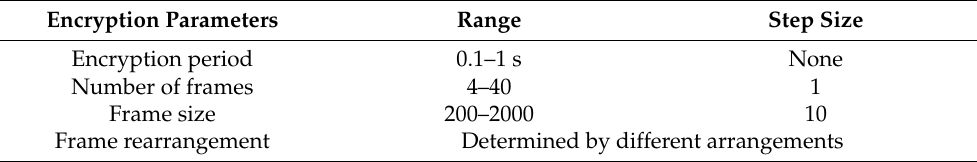
Table 3. Voice call encryption parameters range and step